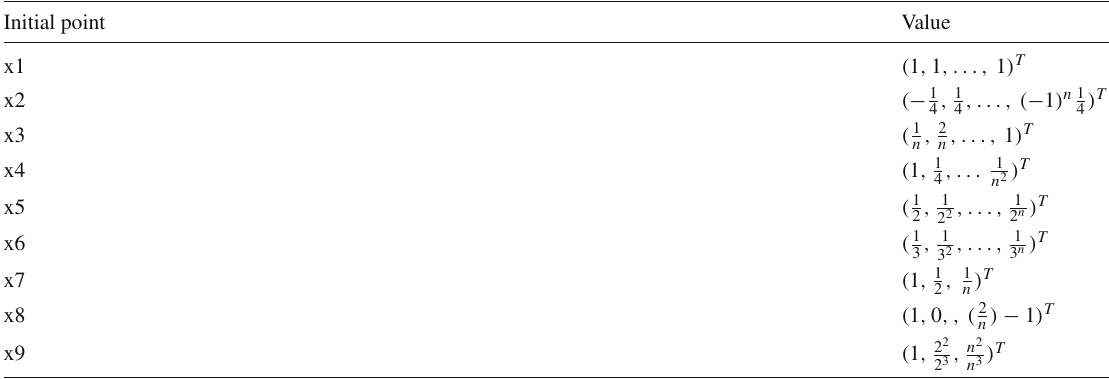
Table 1 Initial starting points used for the test problems Initial point